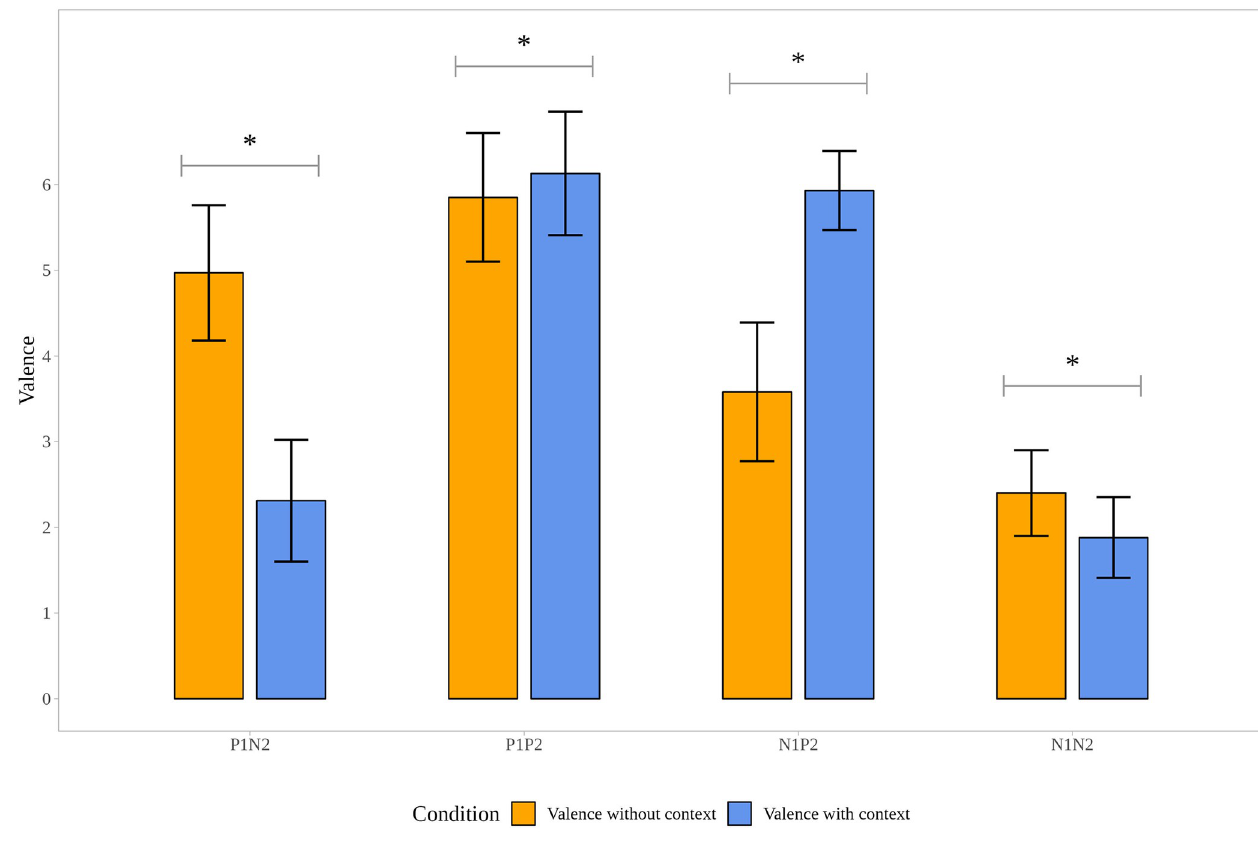
Fig 3. Changes in valence ratings in the post-task. Note. P1: First picture of the picture pairs is positive. N1: First picture of the picture pairs is negative. P2: Second picture of the picture pairs is positive. N2: Second picture of the picture pairs is negative. � p < .001.